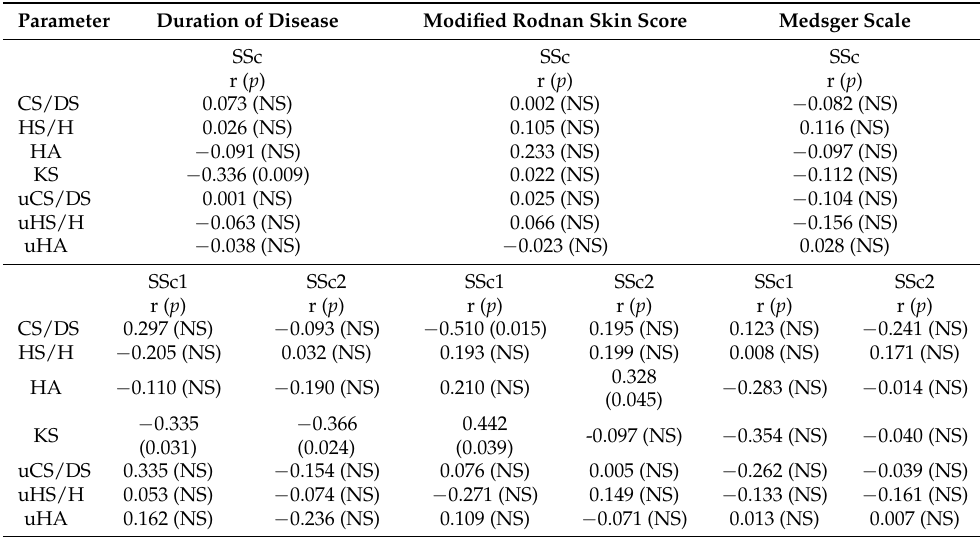
Table 4. Correlation analysis between plasma and urine concentrations of particular types of gly- cosaminoglycans in patients with systemic sclerosis and disease duration and Rodnan skin score (Pearson correlation coefficients,